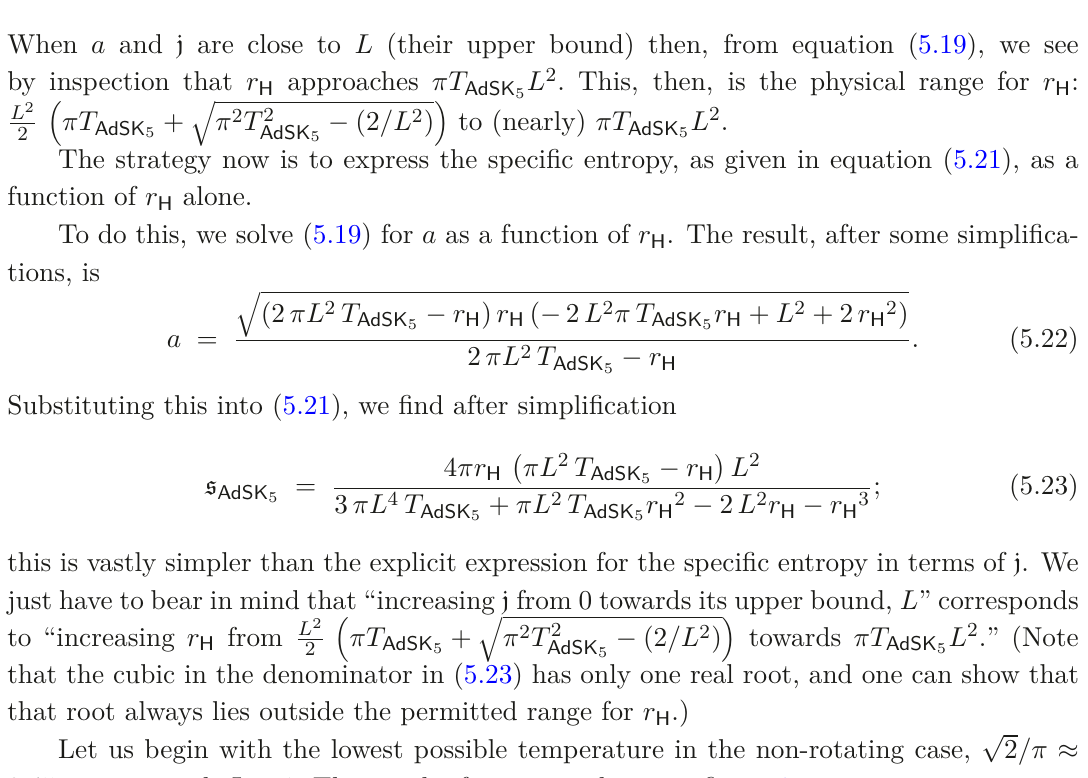
0 . 450 in units with L = 1 , as a function of r H . ≈ 0 . 707 r H < 1 . 414 , corresponding to 0 ≈ ≤ ≈